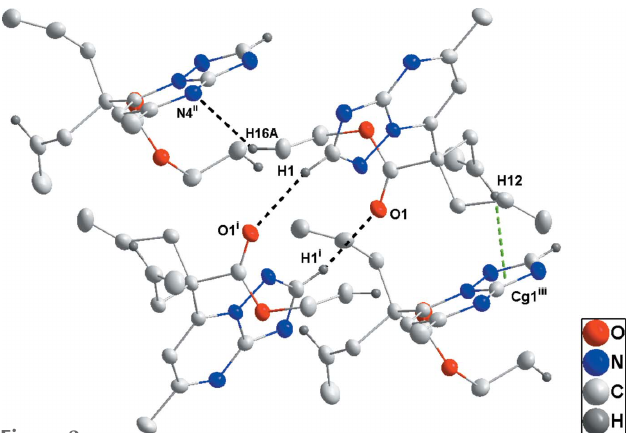
Figure 2 Detail of the intermolecular interactions, with C—H (cid:3)(cid:3)(cid:3) O and C—H (cid:3)(cid:3)(cid:3) N hydrogen bonds shown as black dashed lines, while the C—H (cid:3)(cid:3)(cid:3) (cid:2) (ring) is shown as a green dashed line. [Symmetry codes: (i) (cid:5) x + 1, (cid:5) y + 1, (cid:5) z + 2; (ii) (cid:5) x + 3 , y + 1 , (cid:5) z + 3 ; (iii) (cid:5) x + 1 , y + 1 , (cid:5) z + 3 .] 2 2 2 2 2 2